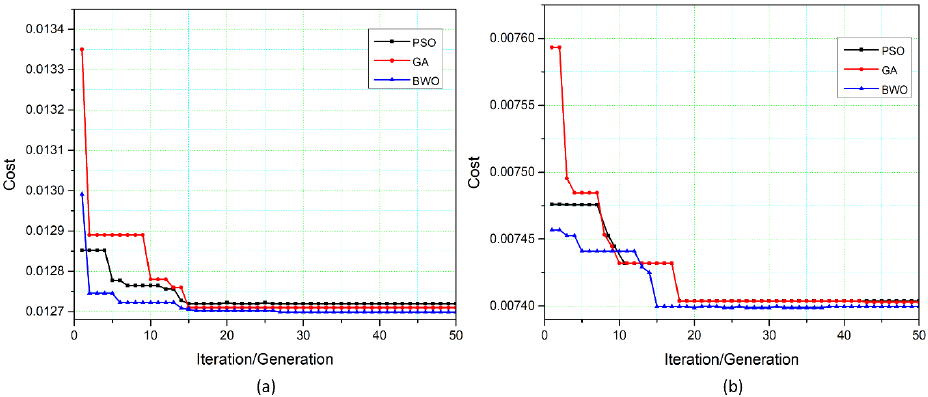
Figure 9. Evaluation of the cost for the B.W.O., the PSO, and the G.A. algorithms, ( a ) cruise condition and ( b ) climb condition.